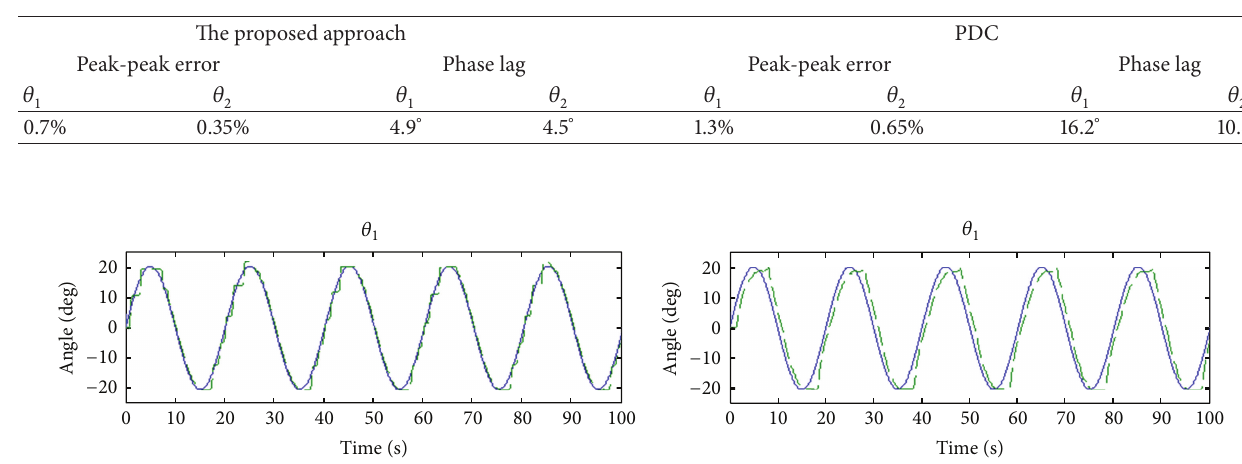
Table 2: Peak-peak error and phase lag for Figure 5.